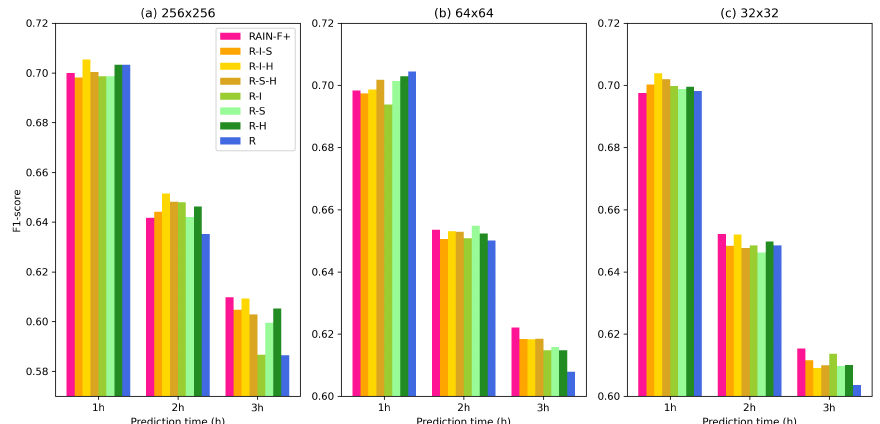
Figure 7. The F1-scores with the rain rate threshold of 0.1 mm/h depending on the fused dataset and the input resolution for the prediction time (R: Radar; I: IMERG; S: Surface observations; H: